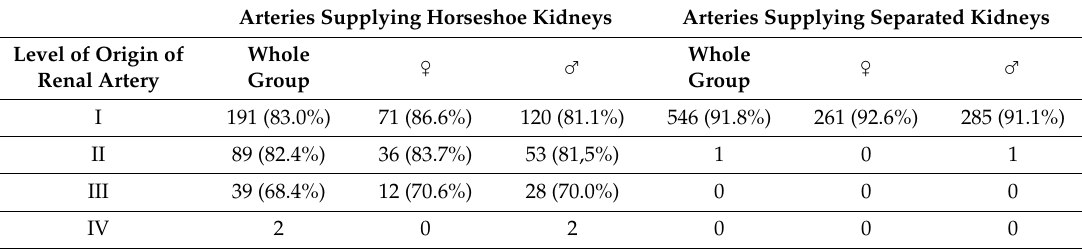
Table 4. Frequency of renal arteries of diameter higher than 3.0 mm according to level of their